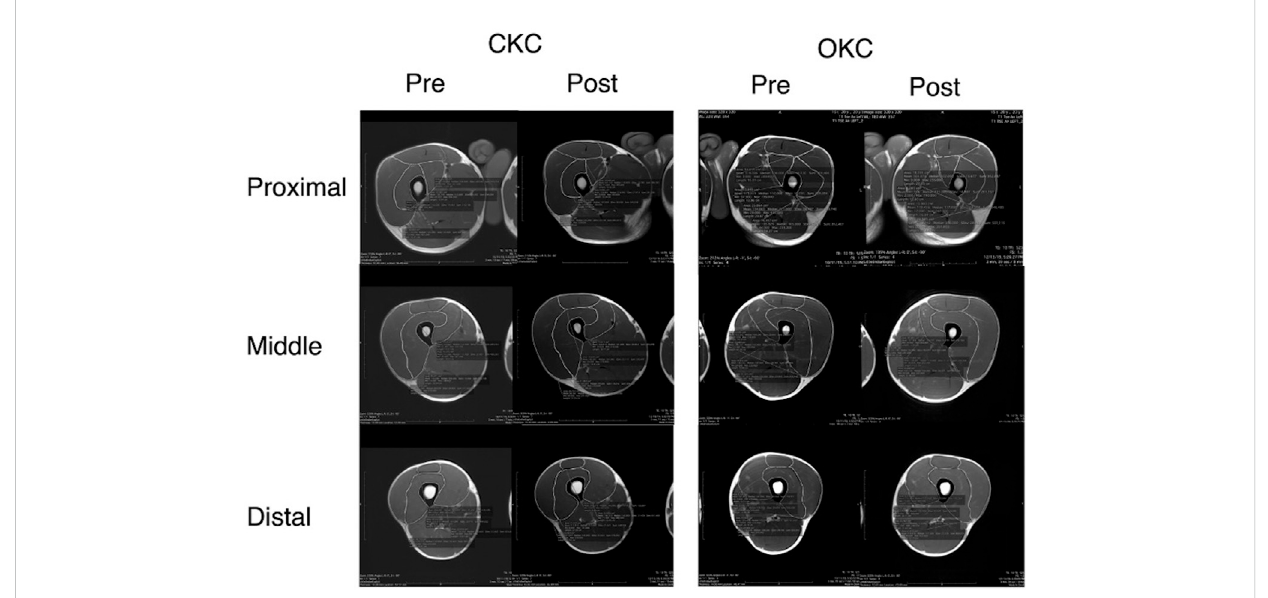
FIGURE 1 ArepresentativesubjectMRIresults.Figurereportsthemeasurementsofeachcomponentofthequadricepsfemorisat33%(Proximal),50%(Middle) and 67% (Distal) of the distance from the femoral head to the tibial tuberosity. Images are before (Pre) and after (Post) 8 weeks of closed kinetic chain (CKC) or open kinetic chain (OKC) resistance training